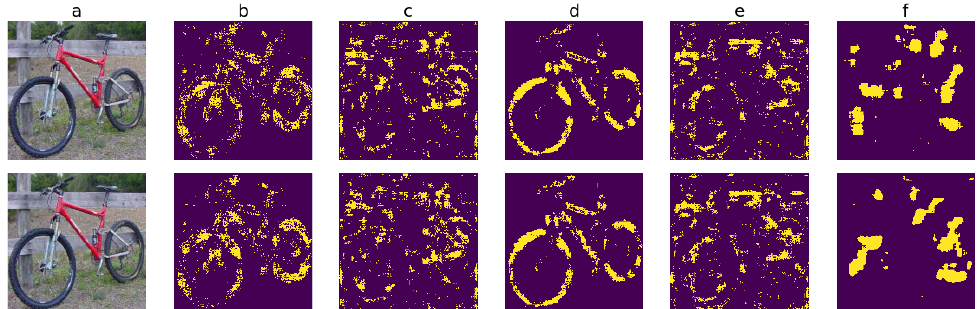
Figure 6. Heatmaps obtained with the ancestor A = A 8 D atk ( A 8 ) pictured in ( a ), where atk = EA in the 1 st row and atk = BIM in the 2nd row. From 6 10 ( b – e ), the heat maps are created using BagNet-17 and represent the following: 10% smallest values of c a ( P ( D ( A ))) − c a ( P ( A )) ( b ); 10% largest values of c t ( P ( D ( A ))) − c t ( P ( A )) ( c ); 10% largest values of c a ( P ( D ( A ))) − c t ( P ( D ( A ))) ( d ); 10% largest values of c t ( P ( D ( A ))) − c a ( P ( D ( A ))) ( e ). Heatmap ( f ) is obtained with C k and represents the 10% largest values of c t ( IP ( D ( A ))) − c t ( A )